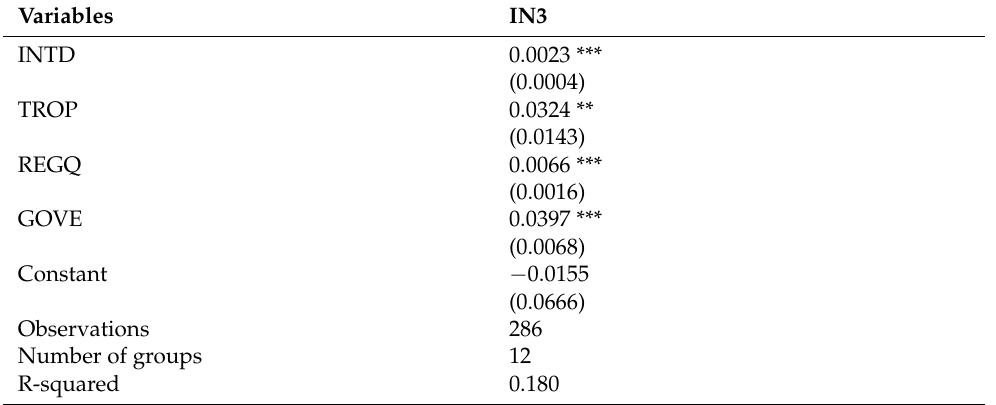
Table 18. Model 8. DV: Income Share of the Bottom 60%